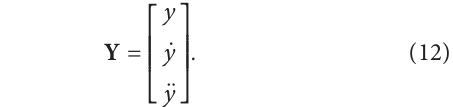
Figure 3: The chaotic system (1) has a class 3 fractal basin that extends to infinity and with a noninteger power law